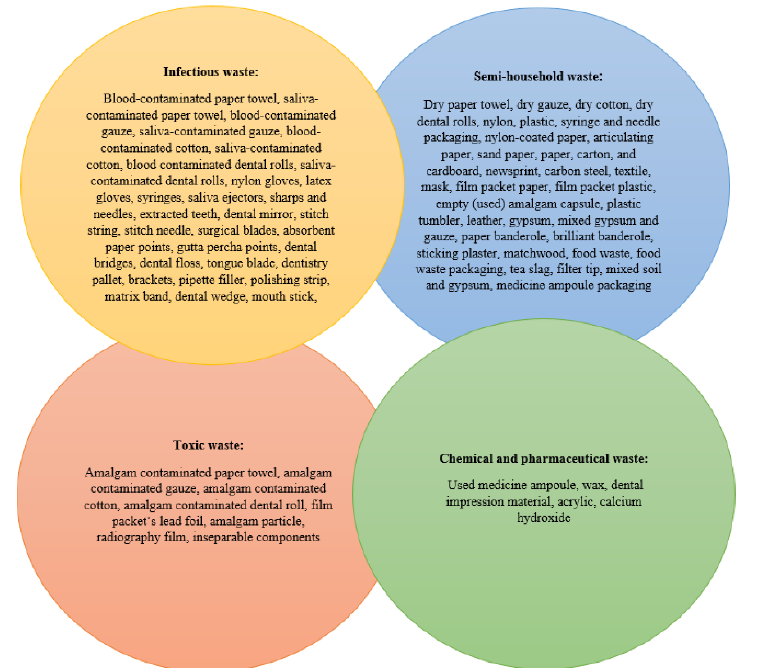
Fig. 2. Categorization of types of dental wastes in Iran 1,